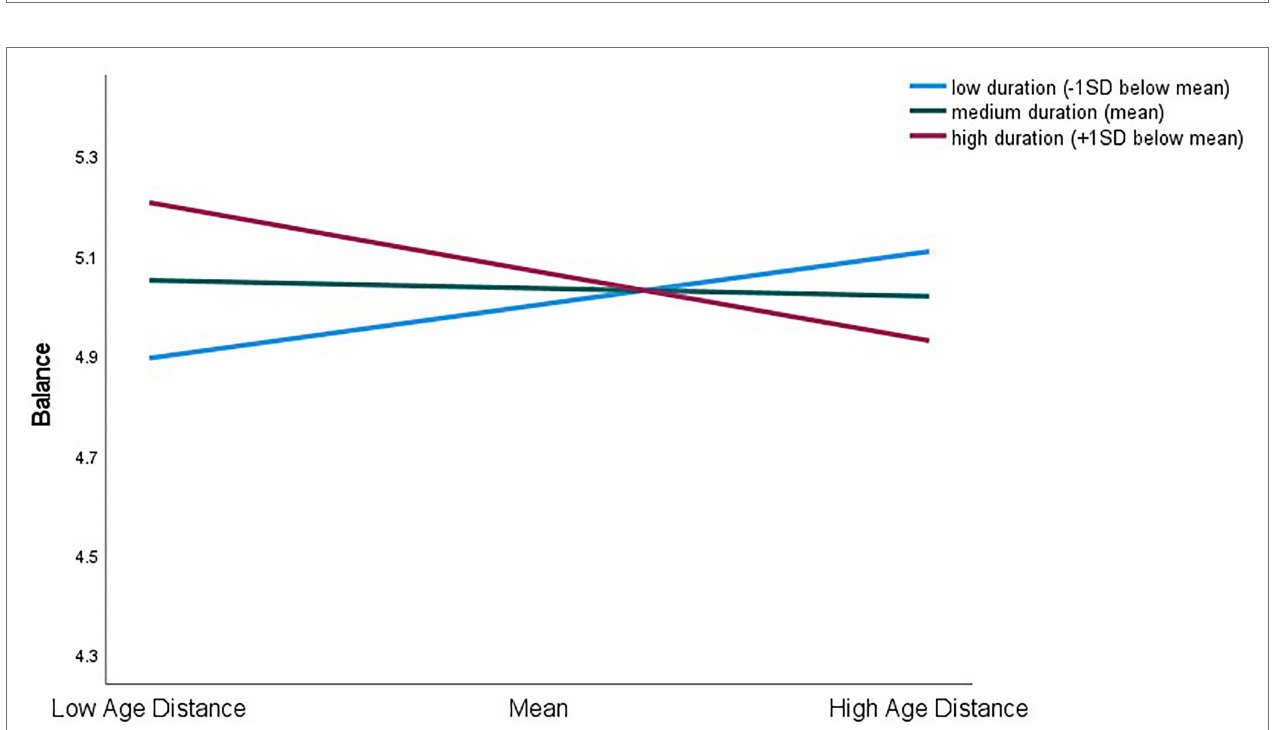
FIGURE 1 | Interaction effects between Age Distance and duration of supervisory relationship for prediction of supervisory ratings of Personal Flexibility.